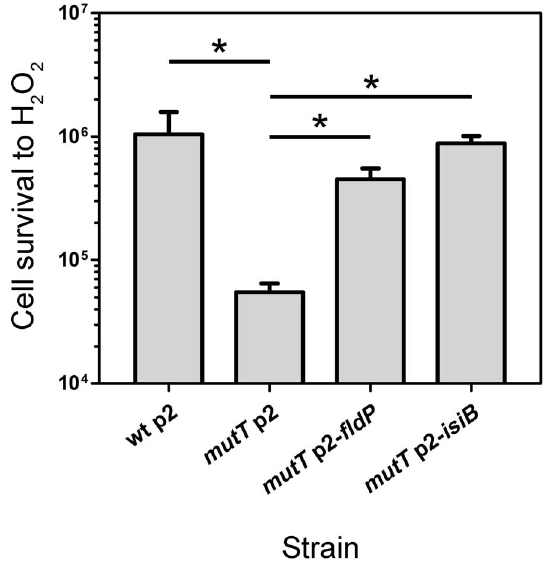
Figure 4. FldP mitigates H 2 O 2 -induced cell death in a mutT - deficient P.aeruginosa . The mutT mutant strain (transformed with the empty plasmid p2) was tested for resistance to H 2 O 2 , and compared with its wt parental strain (harboring p2), and with mutT mutants transformed with p2- fldP or p2- isiB . Bacterial cultures were normalized to , 10 8 cells and then incubated with 50 mM H 2 O 2 for 30 min at 37 u C. Viability was estimated as described in Materials and Methods. Measurements were carried out in triplicate for two independent experiments, and the results were expressed as means with their 6 SEM. Statistically significant differences ( P , 0.05) are identified by * (one-tailed Mann-Whitney test). doi:10.1371/journal.pgen.1004163.g004 using expression of the constitutive housekeeping rpoD gene as control for equal amounts of cDNA in each reaction. Figure 6 shows that expression of fldP in the wt strain was clearly induced (3.9 6 0.7-fold relative to untreated cultures, P = 0.004), after H 2 O 2